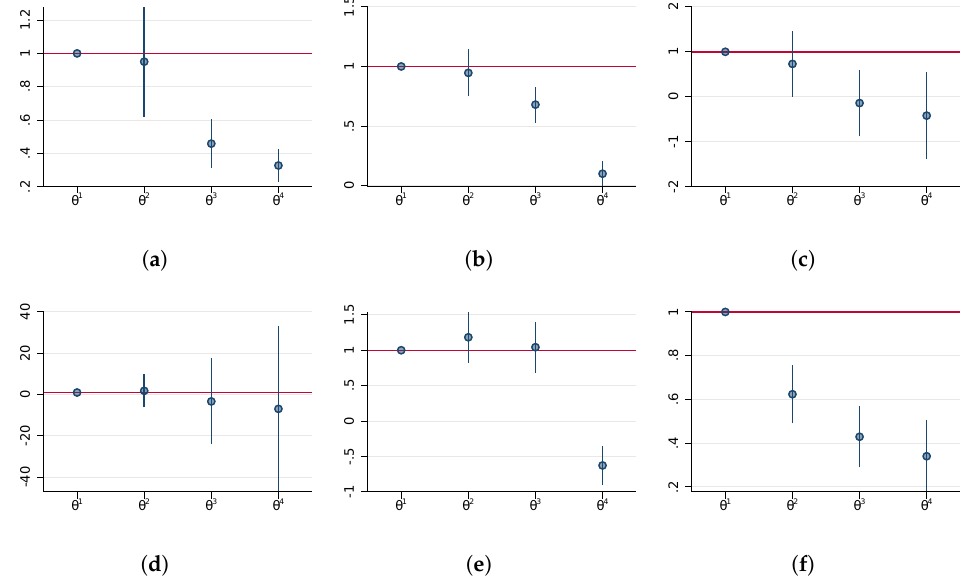
Figure 3. Estimates of relative measurement errors for samples split by quartiles of average GDP. ( a ) USA, ( b ) Germany, ( c ) Italy, ( d ) Spain, ( e ) Brazil, ( f )